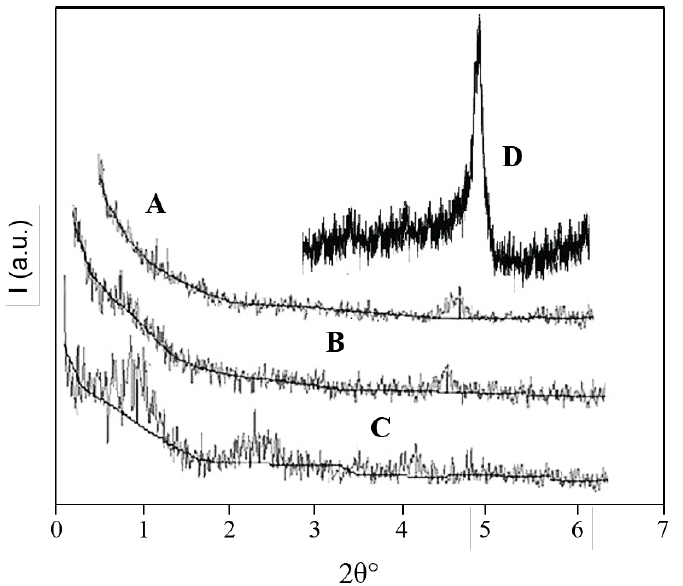
Figure 4. Results of XRD for samples: ( A ) LPS/CNPs 1%, ( B ) LPS/CNPs 3%, ( C ) LPS/CNPs 5%, and ( D ) neat CNPs.